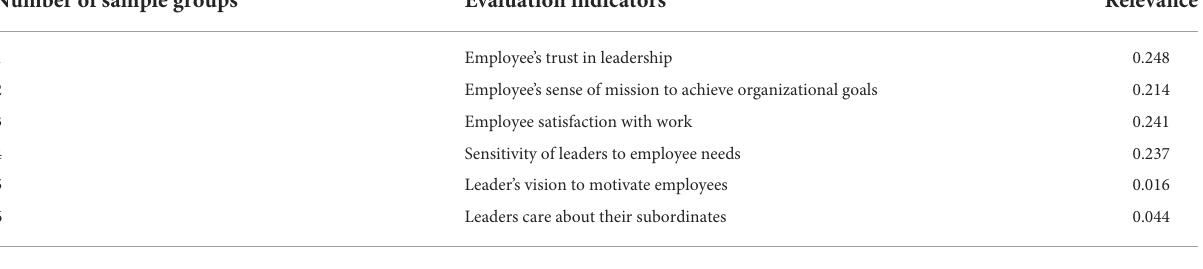
TABLE 4 Effectiveness analysis result table.